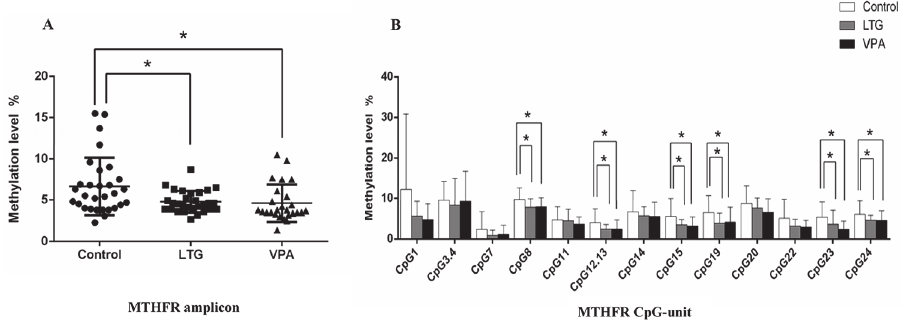
Fig 3. A Methylation levels of the MTHFR amplicon among the control, LTG and VPA groups. B Methylation levels of informative CpG units in the MTHFR amplicon among the control, LTG and VPA groups. * P < 0.05. Abbreviations : MTHFR : methylenetetrahydrofolate reductase; LTG: lamotrigine; VPA: